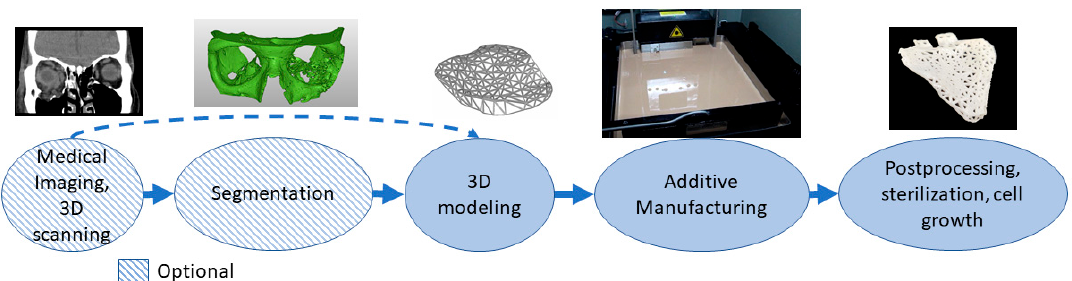
Figure 6. Typical process flow for biomanufacturing.